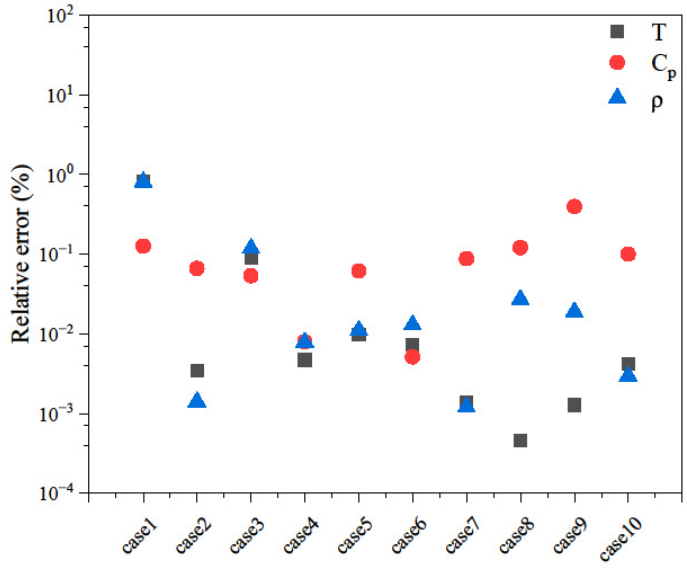
Figure 5. Relative error in 𝑓(𝑝, ℎ) .